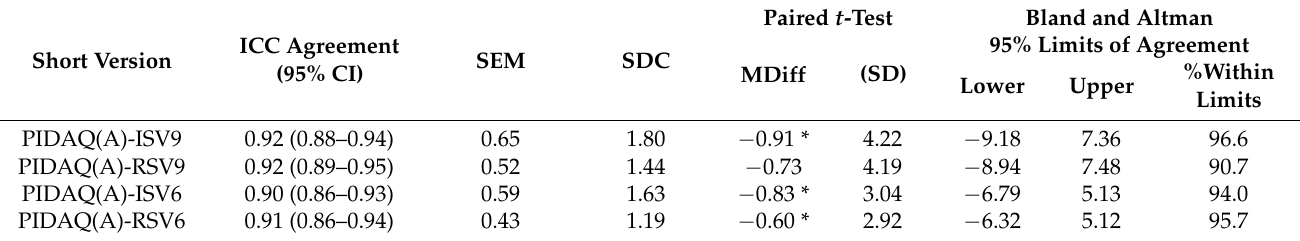
Table 7. The reproducibility assessment for the Arabic PIDAQ short versions.